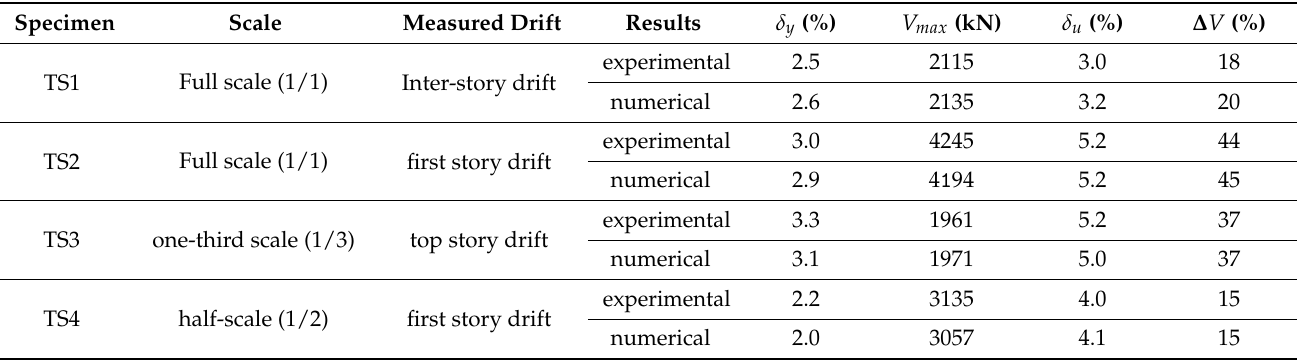
Table 2. Results of cyclic pushover analyses for some SPSW experimental tests and solved numerically by INSPECT-SPSW.